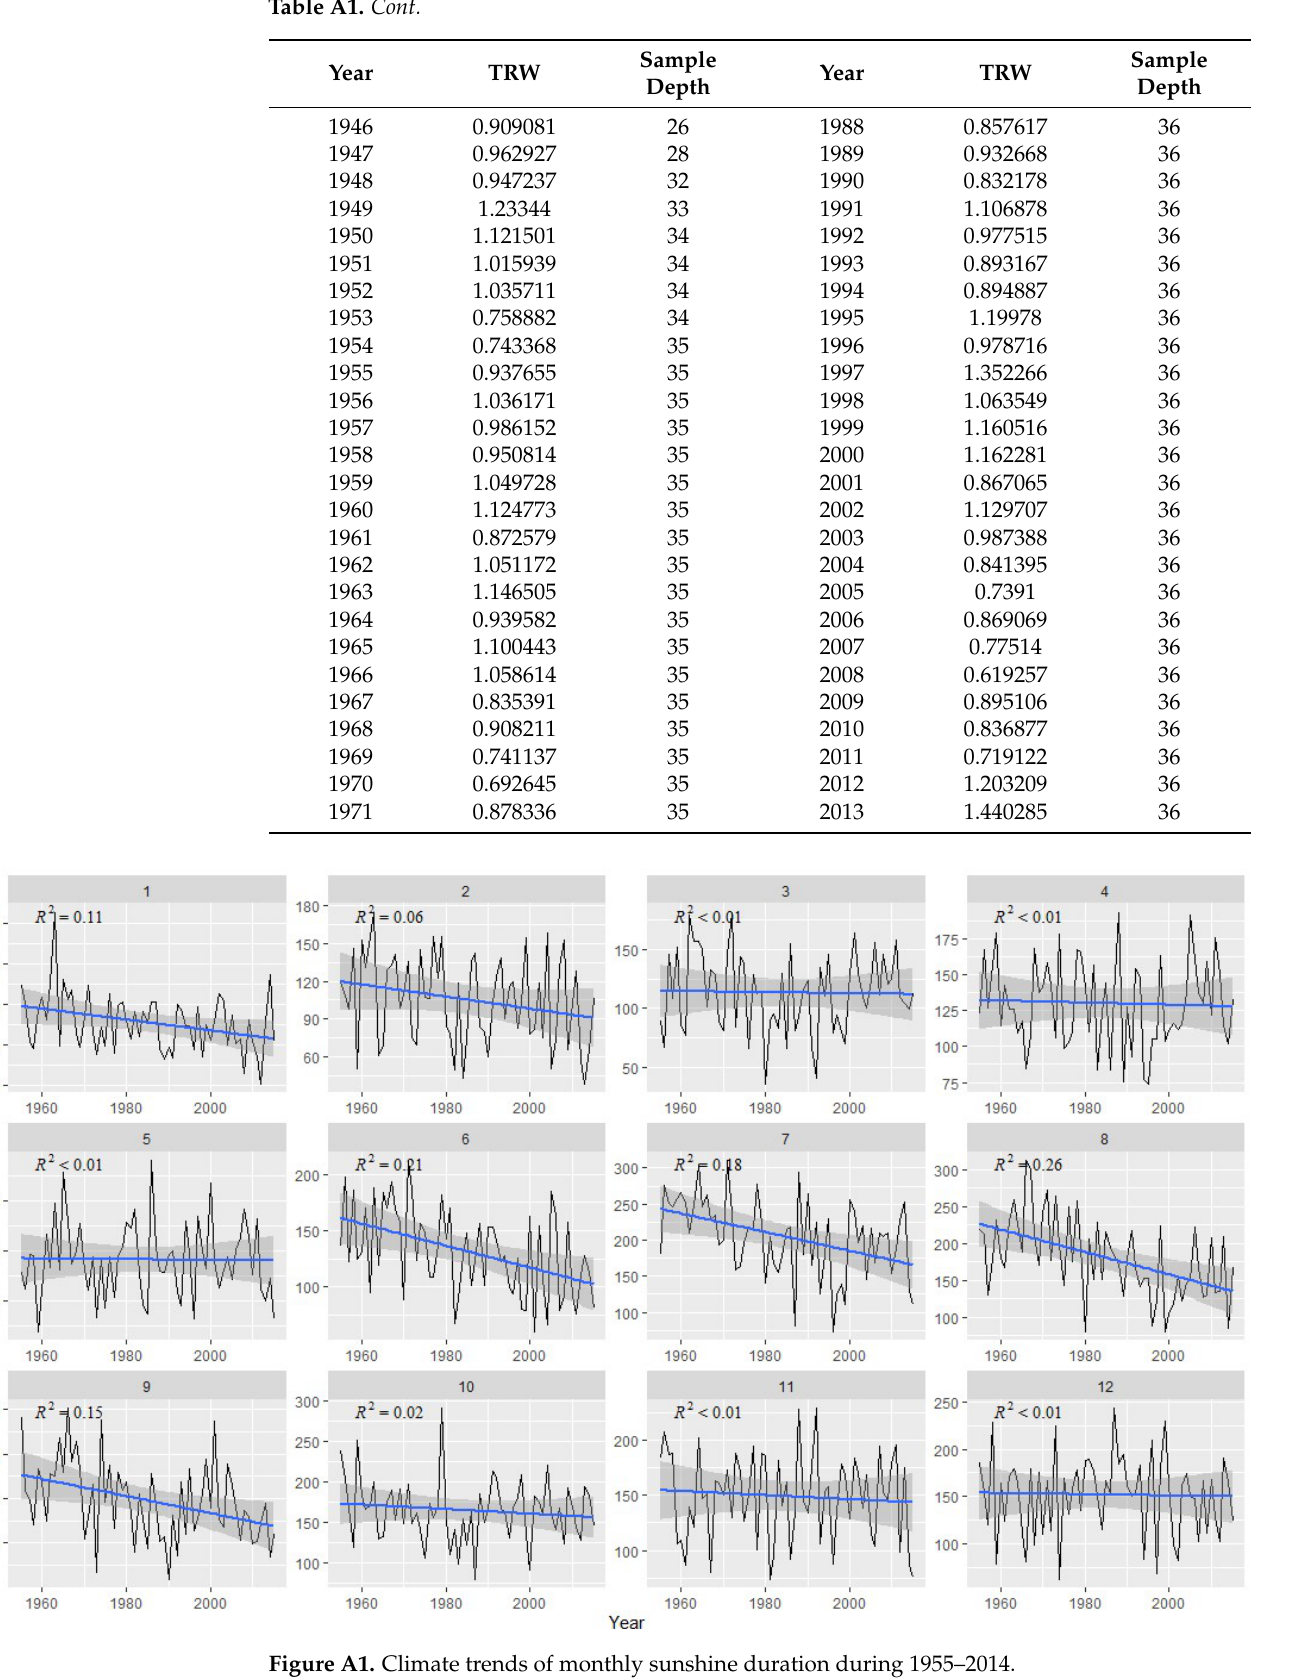
Figure A1. Climate trends of monthly sunshine duration during 1955–2014.